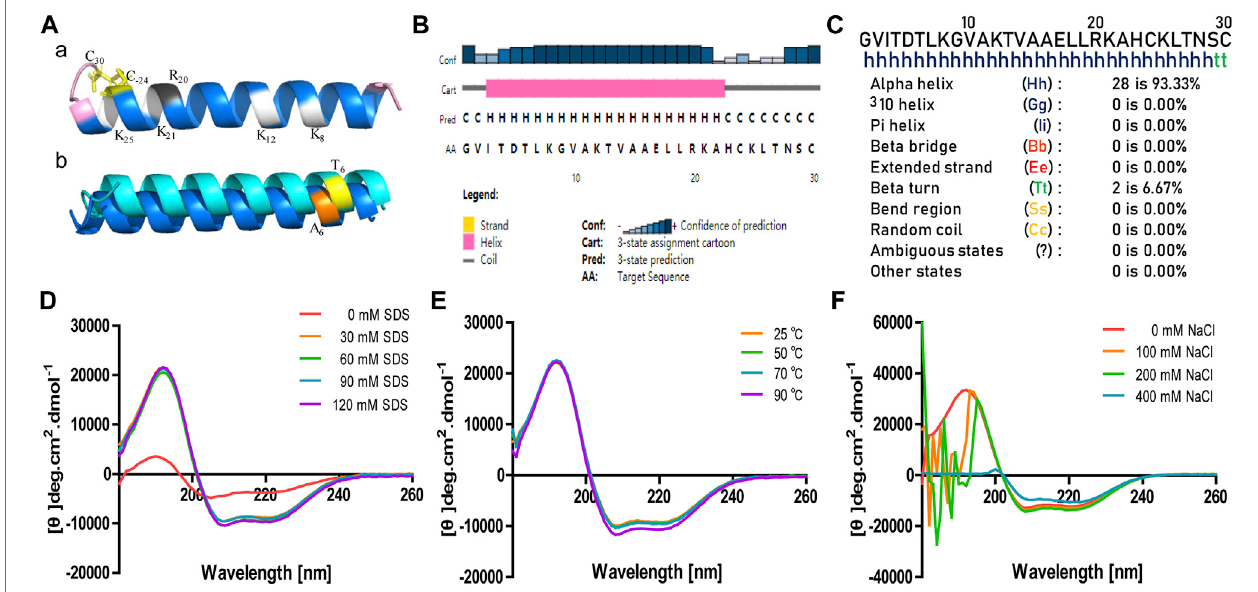
FIGURE2| ThepredictedsecondarystructureandCDanalysisofbrevinin-2MP. (A) Secondarystructuremodelingofbrevinin-2MPproducedbytrRosetta(a)and secondary structure comparison of brevinin-2MP and brevinin-2GHb (b) visualized with PyMOL. The predicted brevinin-2MP structure is shown in the form of ribbons, withskyblueindicating α -helixandpinkindicatingirregularcoils,andthedifferentaminoacidsofbrevinin-2MPandbrevinin-2GHbarelabeledwithdifferentcolors. (B , C) Secondary structures of brevinin-2MP predicted by the Jpred4 and SOPMA secondary structure prediction servers provided by the Division of Computational Biology, School of Life Sciences, University of Dundee and PBIL-IBCP of the Institute of Biology and Protein Chemistry. (D – F) The CD spectra of brevinin-2MP in the indicated conditions.